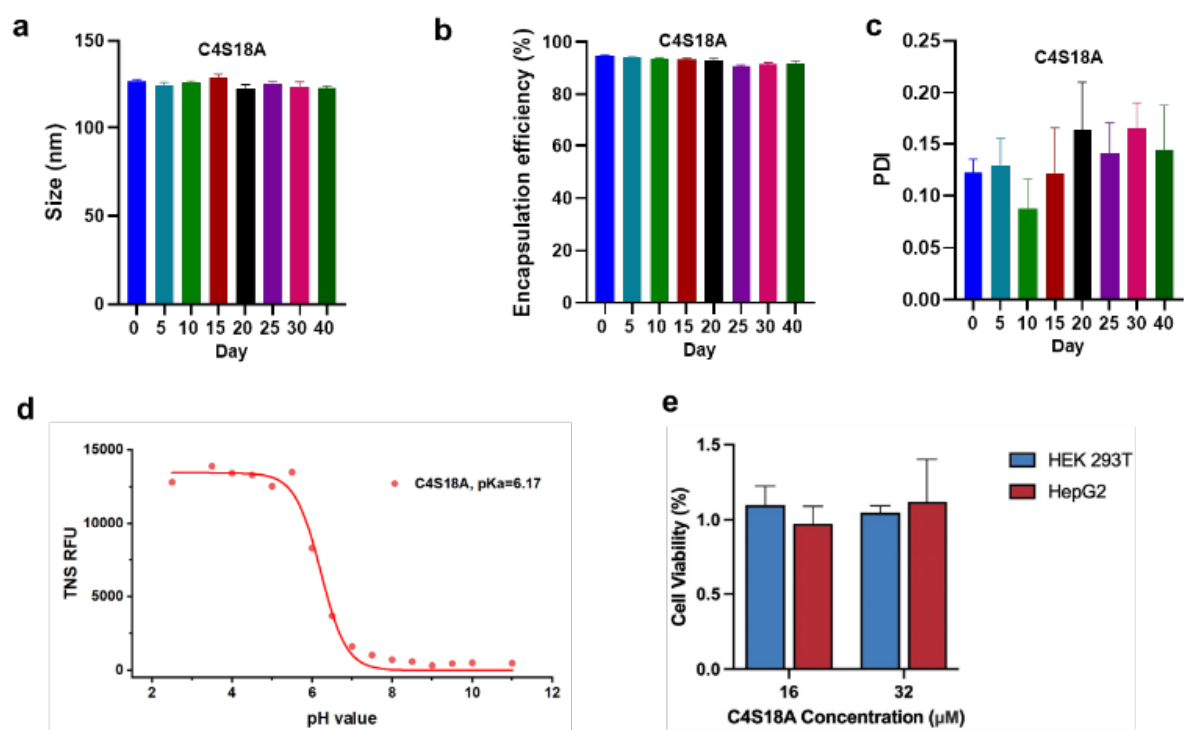
Figure 4. Stability and biological evaluation of mRNA-LNPs. ( a ) Particle size, ( b ) Entrapment efficiency (EE) and ( c ) PDI of LNPs prepared by C4S18A change over time. ( d ) The apparent pKa of LNPs was measured by plotting the TNS fluorescence against pH values. ( e ) Cell viability measured by CCK8 assays using 293T cells and HepG2 cells. Data presented as mean ± SEM of 3 separate